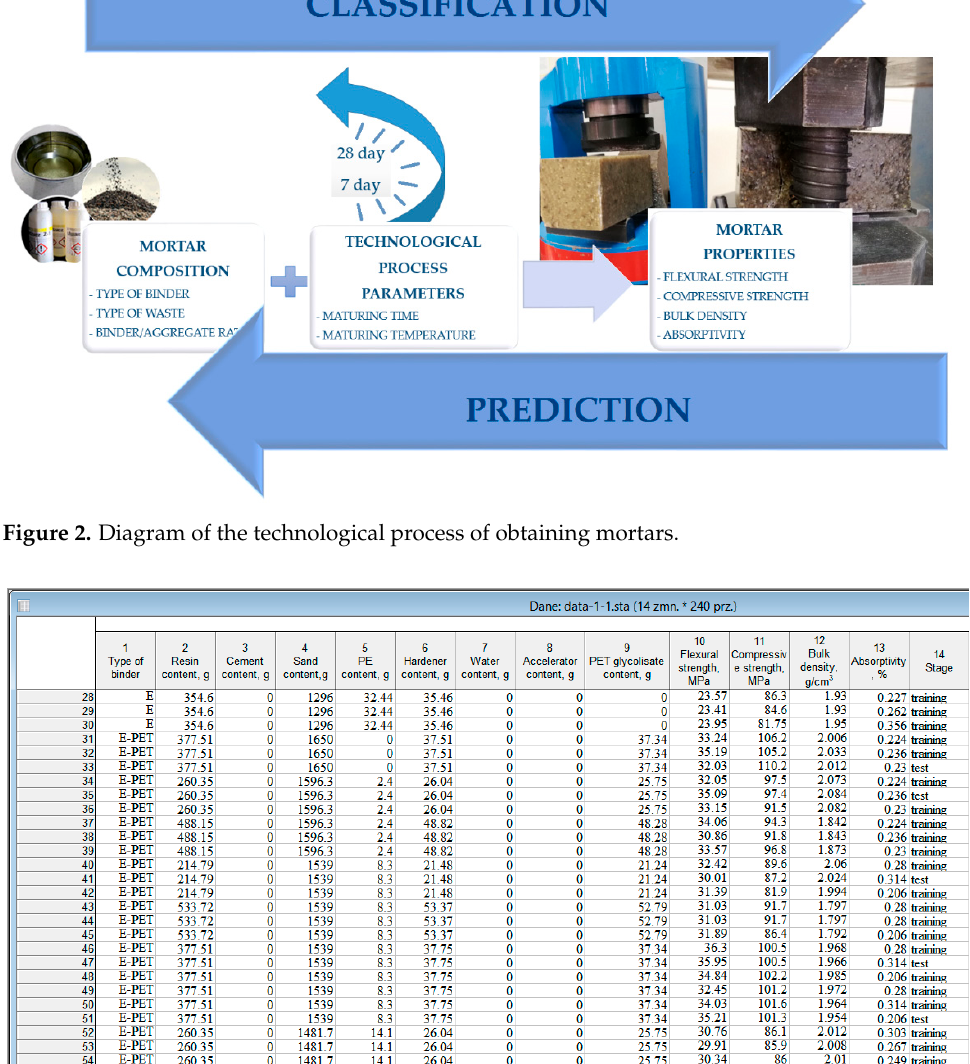
Figure 3. Fragment of the experimental